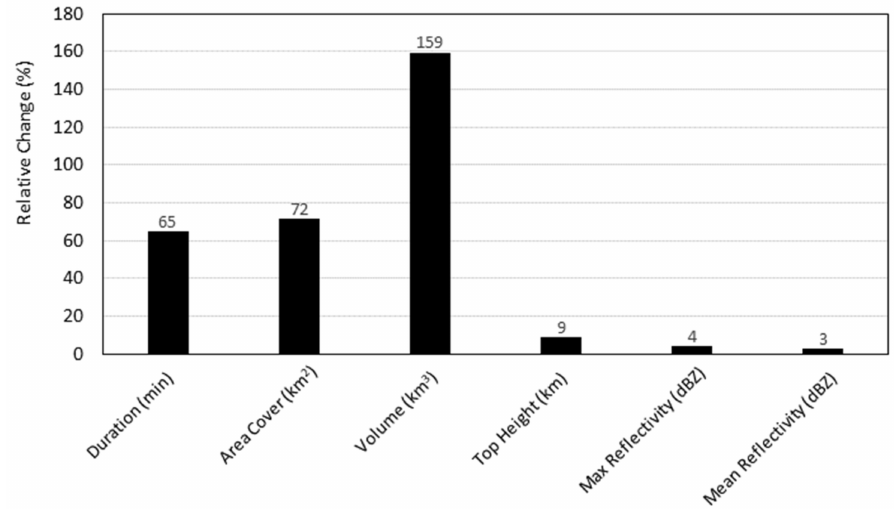
Figure 8. Mean relative change ratios in echo duration, area cover, volume, top height, maximum and mean reflectivity between seeded (65) and unseeded (87) storms recorded during the 2018–2019 summer